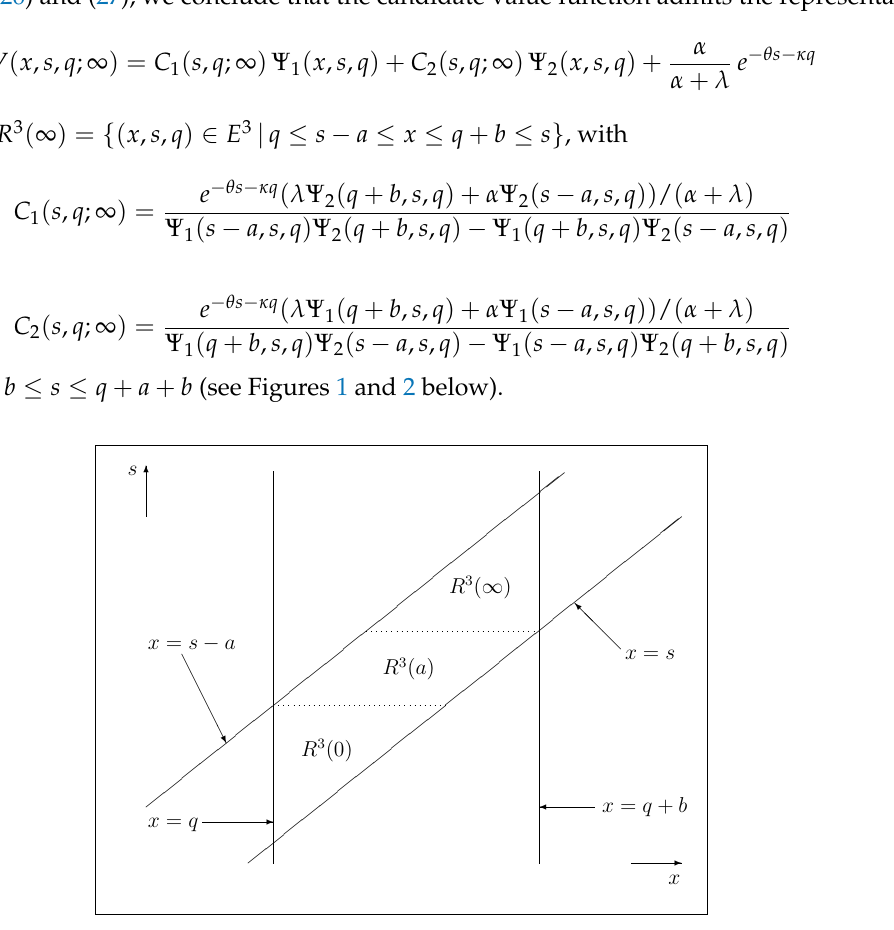
Figure 1. A computer drawing of the state space of the process ( X , S , Q ) , for some q R fixed and a < b .